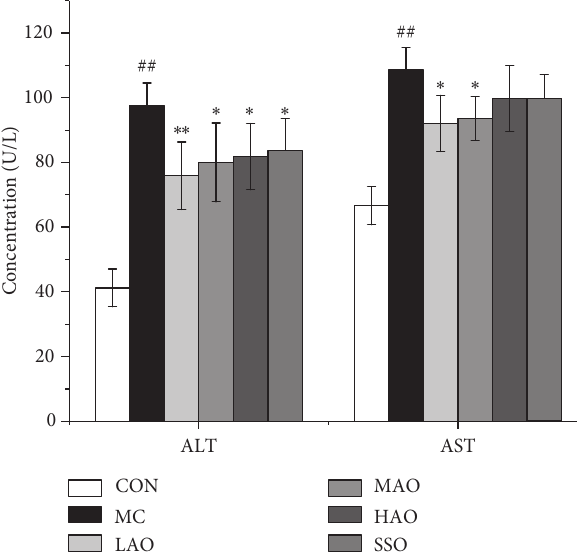
Figure 4: Effects of almond oil on serum TNF- α and IL-1 β in STZ- induced rats. TNF- α , tumor necrosis factor- α ; IL-1 β , interleukin 1 β . Data were expressed as means ± SD. The MC group was compared with the CON group, # P < 0 . 05, ## P < 0 . 01; the LAO, MAO, HAO, and SSO groups were compared with the MC group, ∗ P < 0 . 05, ∗∗ P < 0 .